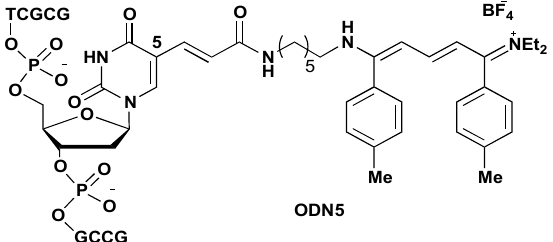
Figure 1. Streptocyanine dye installed on 5-position of thymidine ( ODN5